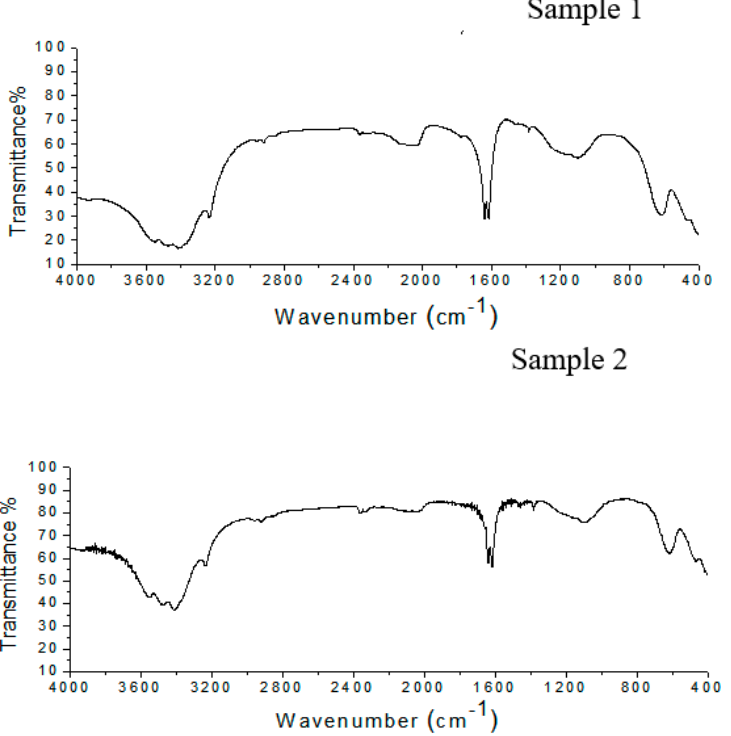
Figure 2. FTIR spectra of Samples 1 and 2, showing the presence of all of the characteristic peaks of the Vi antigen.